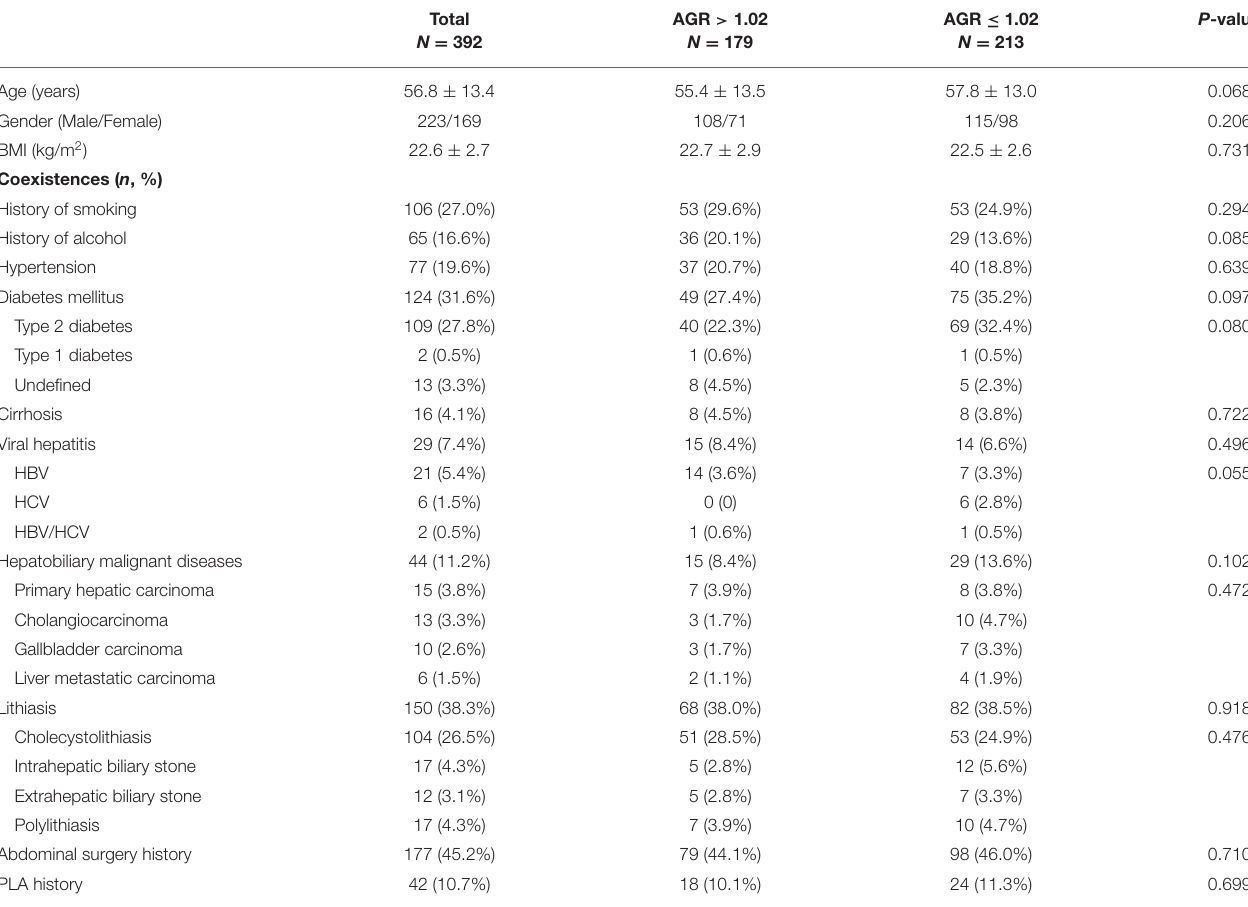
TABLE 1 | Baseline data of demographic data and